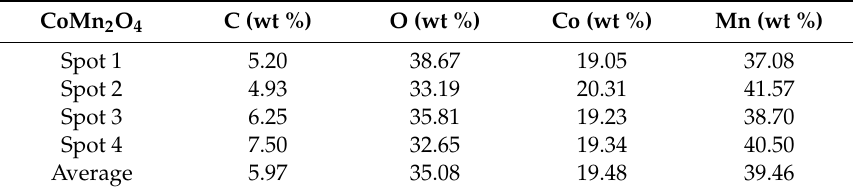
Figure 1. Scanning electron microscopy (SEM) ( a ), transmission electron microscopy (TEM) ( b ) images, and energy-dispersive X-ray (EDX) analysis ( c ) of CoMn 2 O 4 . Table 1. The content of C, O, Co, and Mn on four spots of the CoMn 2 O 4 .